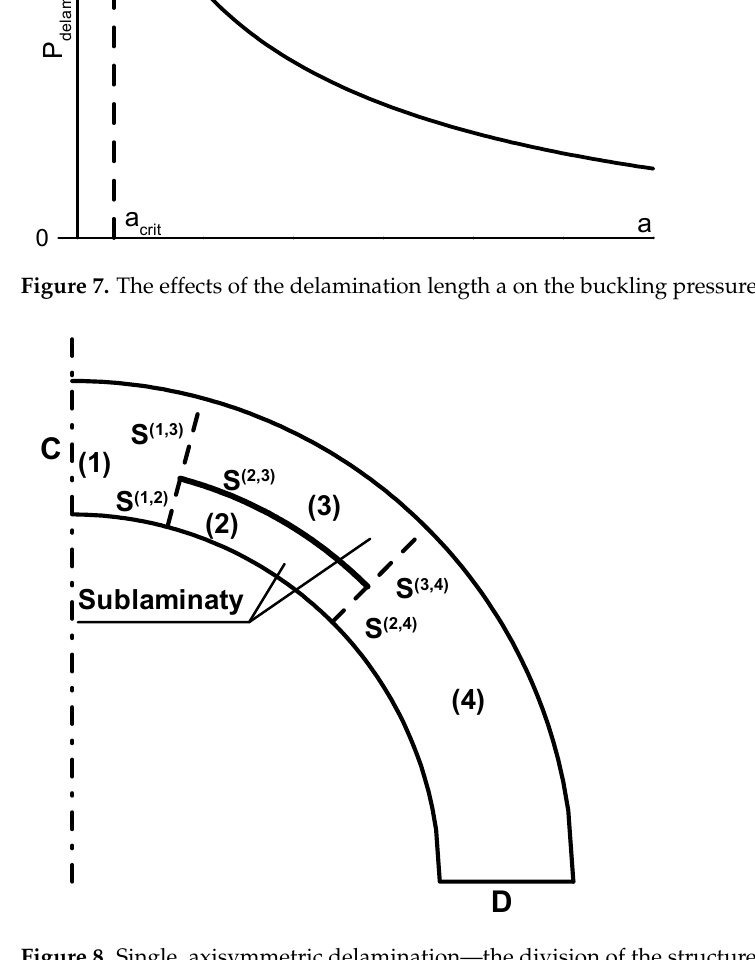
Figure 8. Single, axisymmetric delamination—the division of the structure into sub-laminates. The composite structure represents a 3D body (laminates or functionally graded V k , where V k is a space material, FGM) that is a space occupied by layered structures ∑ N k = 1 occupied by the individual k -th layer description of the layered